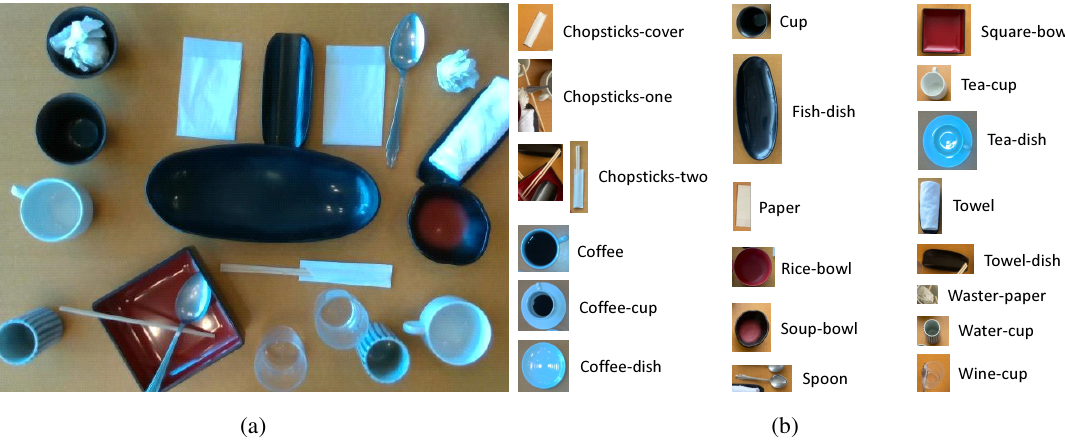
Figure 6. Example of dish image and definition of classes. ( a ) An example of a dish image and ( b ) is the definition of the 20